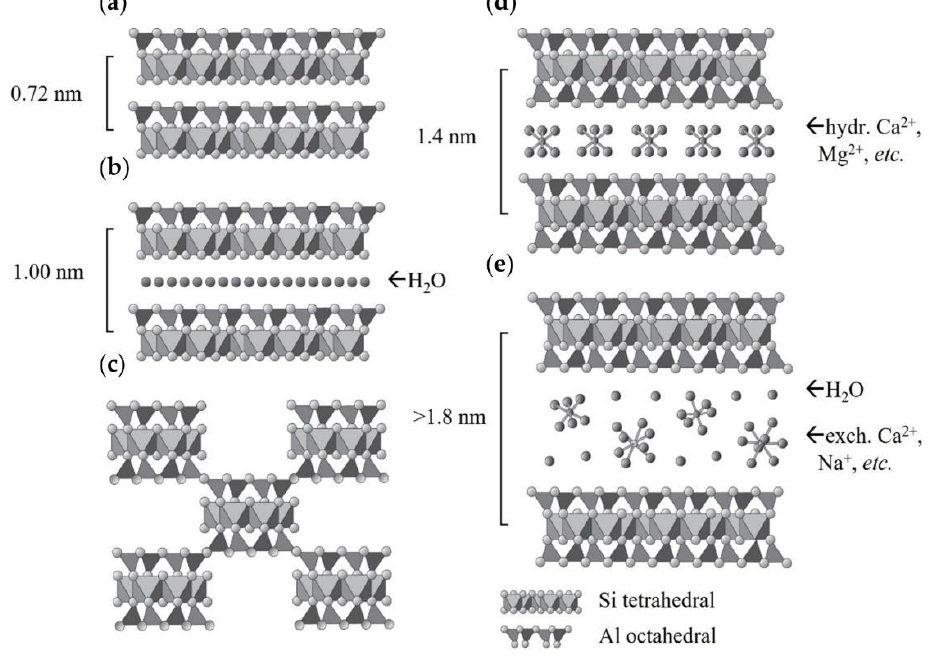
Figure 2. Structural schemes for some of the clay minerals: ( a ) kaolinite; ( b ) halloysite; ( c ) sepiolite; ( d ) vermiculite, and ( e ) smectite (adapted from Schulze 2005) [141]. Fibrous clay minerals, such as palygorskite (attapulgite) and sepiolite, have a unique ar- The interaction between CO 2 and clay minerals has attracted the interest of the rangement of the tetrahedral and octahedral sheets that are distinct from the typical 1:1 and scientific community as such minerals have proven potential to capture carbon [20,24,28]. 2:1-layer types. Palygorskite and sepiolite are composed of continuous two-dimensional silica tetrahedral sheets and one Mg 2+ octahedral sheet, which is continuous in only one dimension. As a result, the tetrahedral sheets are split into ribbons and each of these ribbons are linked to the next ribbon by inversion of silica tetrahedral (Figure 2c). The dimension of channels between the ribbon strips is ranging from 4 to 6 angstroms for paly- gorskite and from 4 to 9.5 angstroms for sepiolite [141,143,158]. Both minerals are of fibrous morphology with micropores of around 0.54 nm in diameter; at the same time,